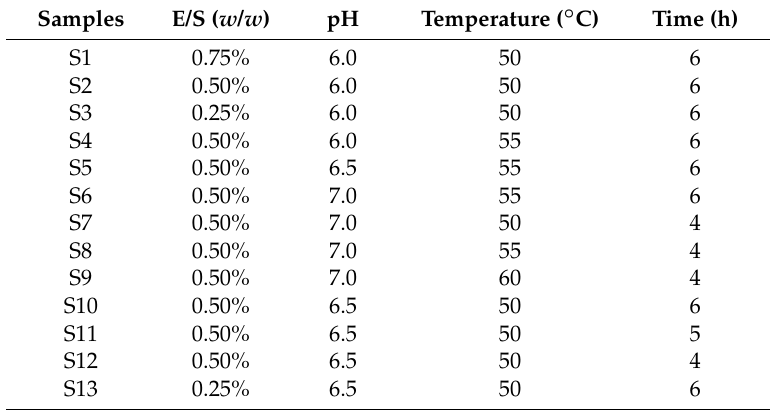
Table 9. The processing conditions of collagen peptides. E/S: enzyme to substrate